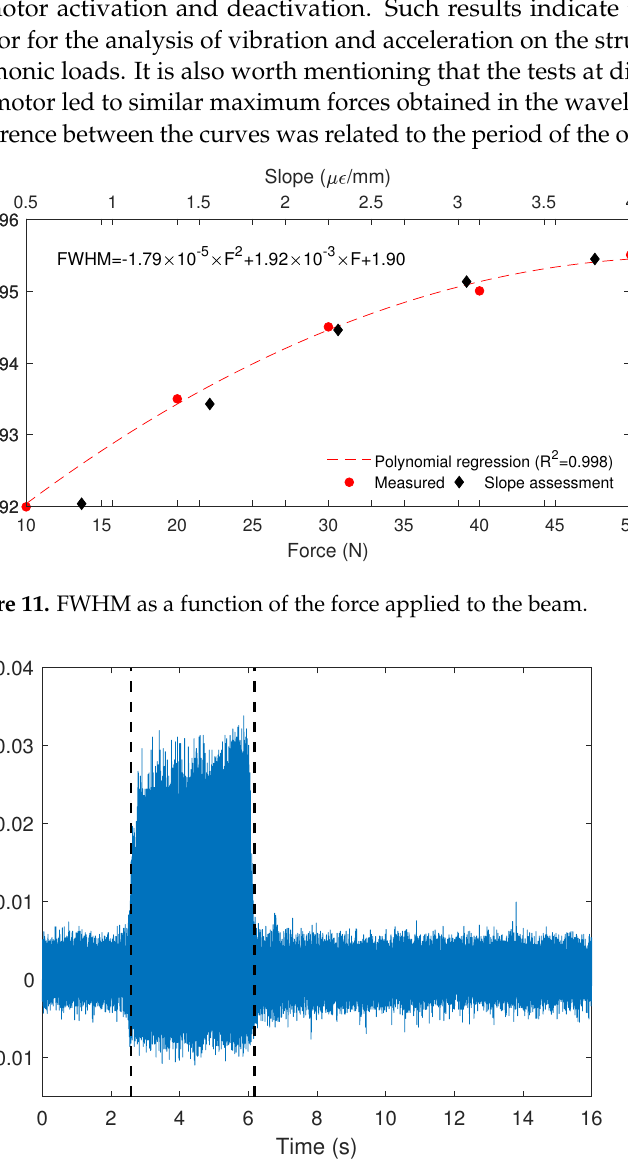
Figure 12. Wavelength shift as a function of the time for the vibration monitoring with the unbalanced motor activation. The dashed lines indicate the time of motor